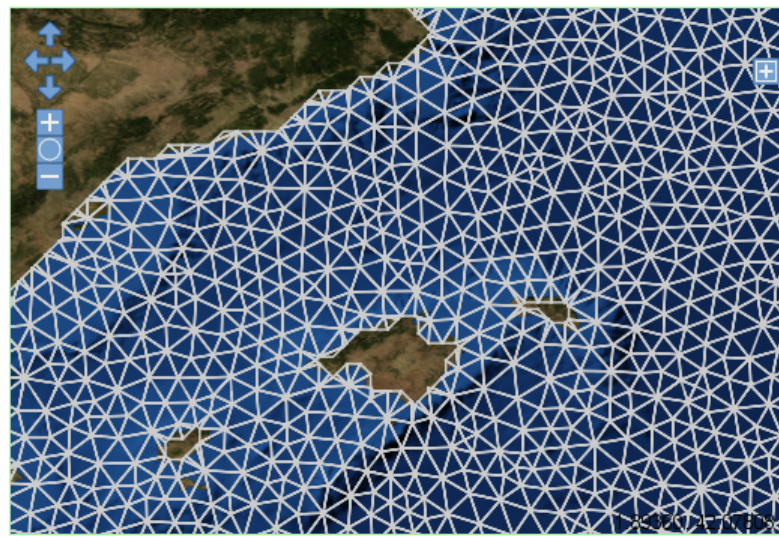
Fig. 3. Detail of the finite element grid of the Balearic Islands. The finite element grid can be visualized in the browser as a WMS (Web Map Service) layer.